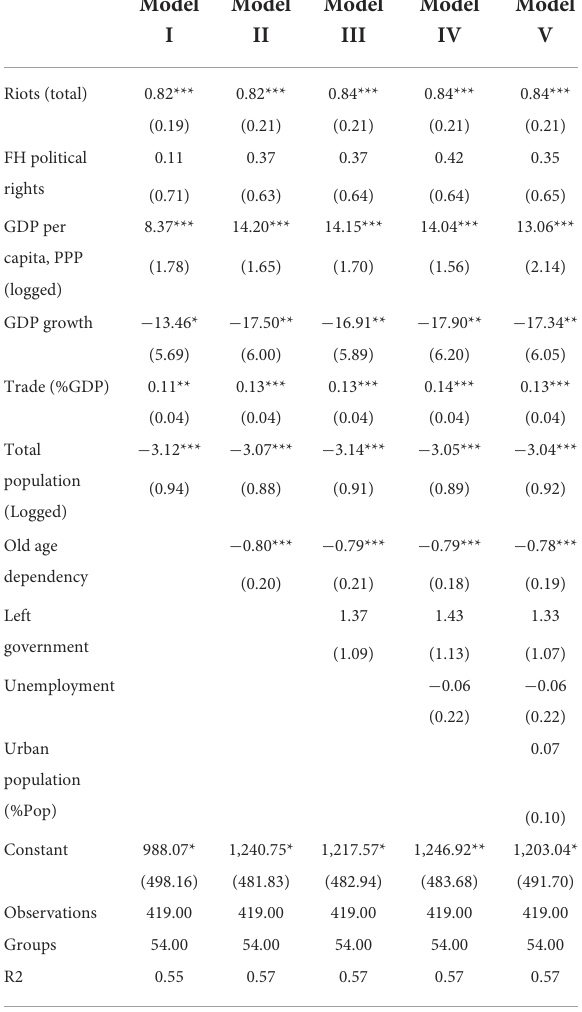
TABLE 3 Social assistance coverage and violent civil